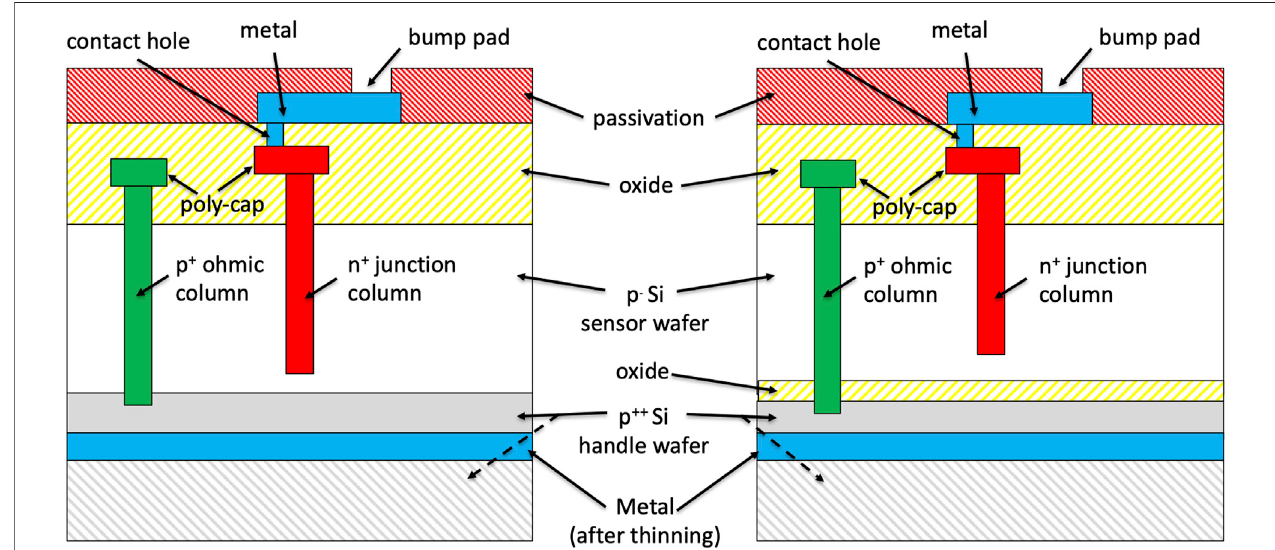
FIGURE 1 | Schematic cross-sections of small-pitch, thin 3D pixels made at FBK with a single-sided approach on: SiSi DWB substrate (left), and SOI substrate (right). Not to scale.